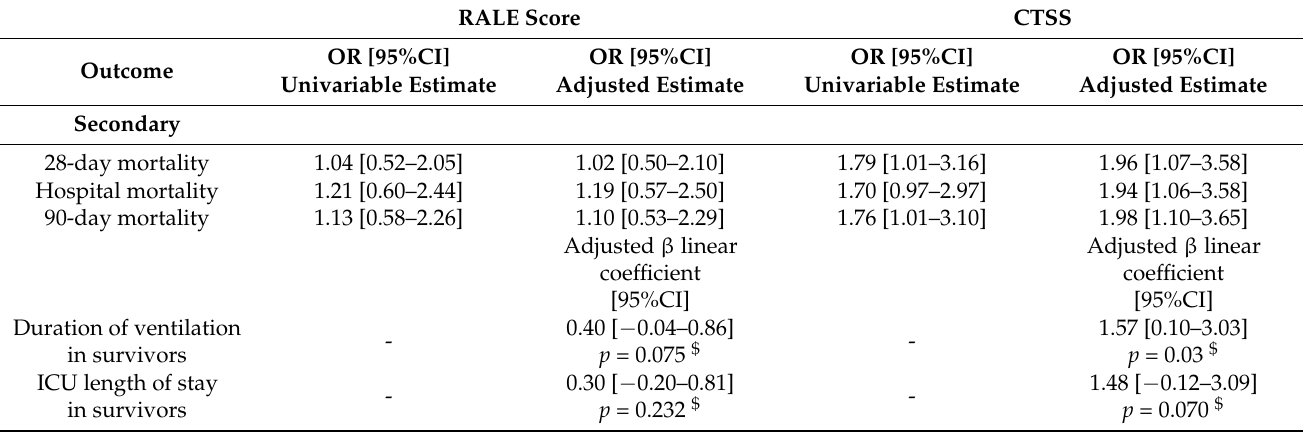
Figure 3. Scatterplot showing the correlation between the RALE score and the CTSS, with the linear regression estimation (in blue), and the 95%CI shown in shaded area. R 2 = 0.075; p = 0.012. Beta coefficient for RALE score: 0.08 [95%CI 0.02–0.16].